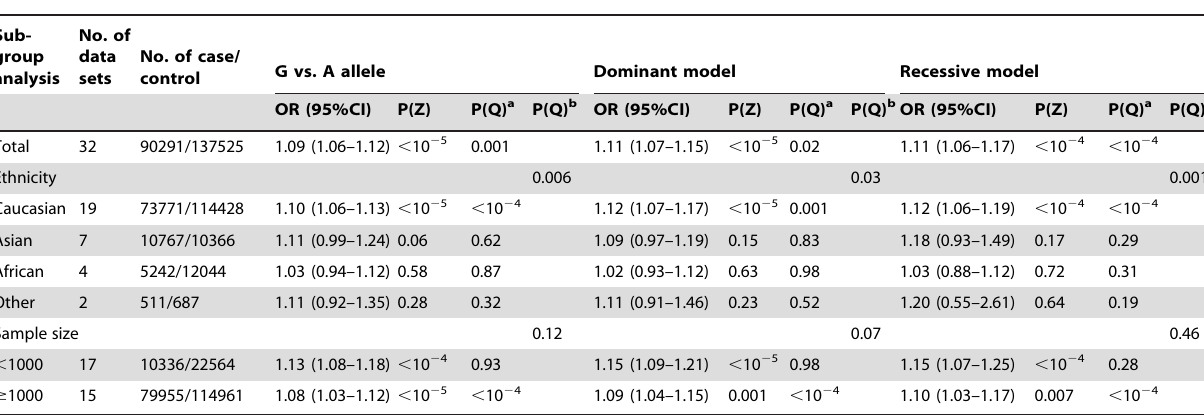
Table 2. Results of meta-analysis for 1p11-rs11249433 polymorphism and BC risk.